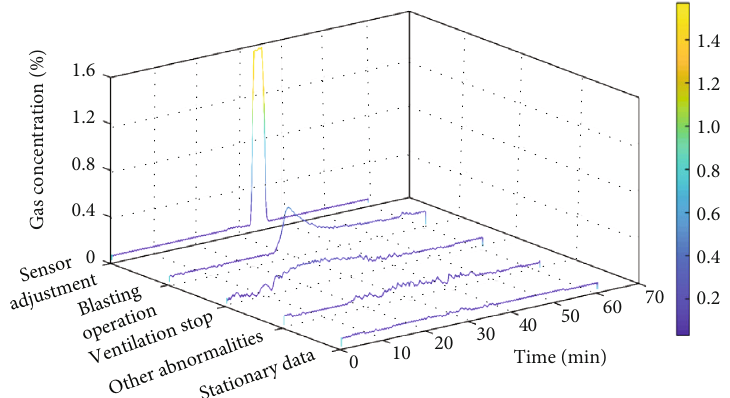
Figure 1: Time series of gas concentration for di ff erent causes.